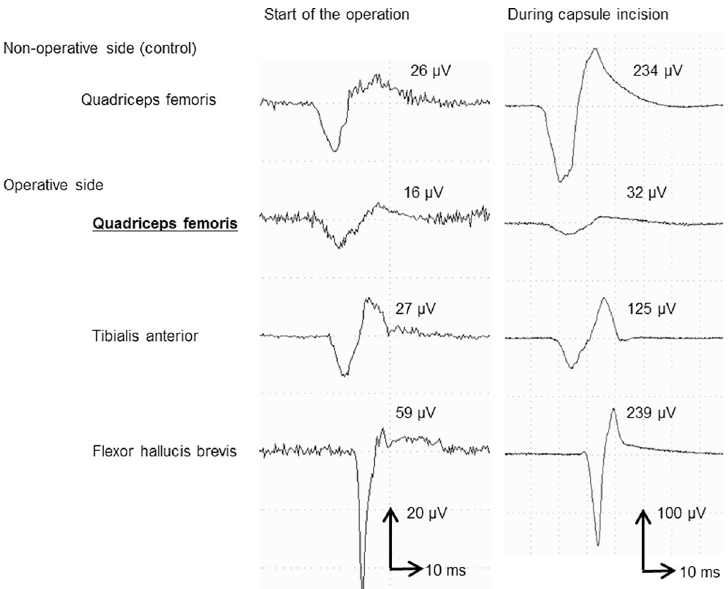
Fig 1. Intraoperative TCE-MEP in Case 3. TCE-MEP of the non-operative side’s quadriceps femoris (control) at this point increased to 900% compared with that at the start of the operation, and TCE-MEP of the operative side’s tibialis anterior and flexor hallucis brevis at this point increased to 463% and 405%, respectively, compared with that at the start of the operation. However, TCE-MEP of the operative side’s quadriceps femoris at this point increased only to 200% compared with that at the start of the operation.